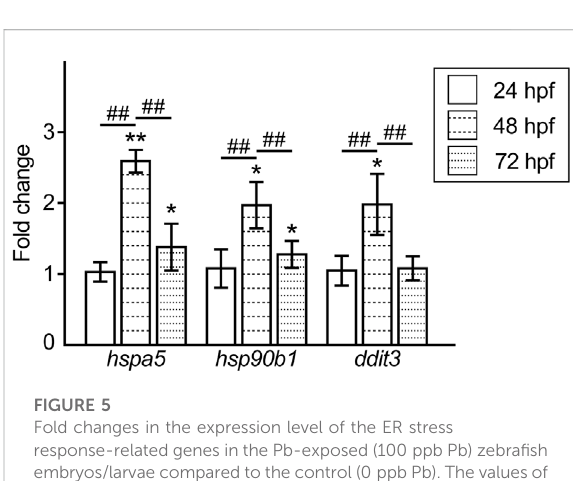
Fold changes in the expression level of the ER stress response-related genes in the Pb-exposed (100 ppb Pb) zebra fi sh embryos/larvae compared to the control (0 ppb Pb). The values of the fold changes at 24, 48, and 72 hpf are shown in the bar graph representing the mean ± SD. Statistical signi fi cance between control and Pb-exposed groups at each time point was calculated by the Student ’ s t-test. * p < 0.05, ** p < 0.01. Statistical signi fi canceamongtime point wascalculated byone-way ANOVA followed by Tukey-Kramer honest signi fi cant difference test. ## p < 0.01. Number of data ≥ 4, n = 30 –